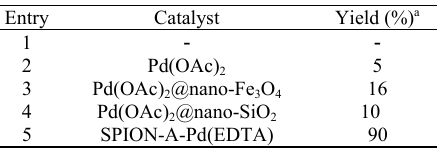
Table 3: Comparison with different catalysts